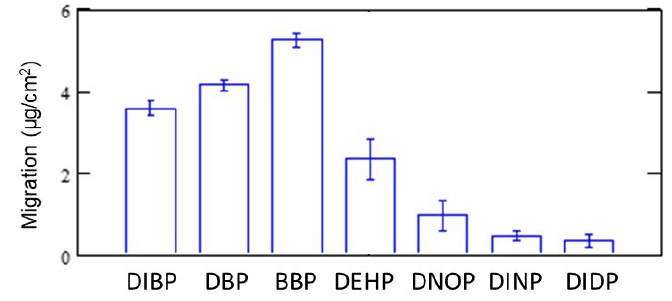
Figure 6. Di ff erences in the migration of major phthalates. The error bars represent one standard deviation of the three